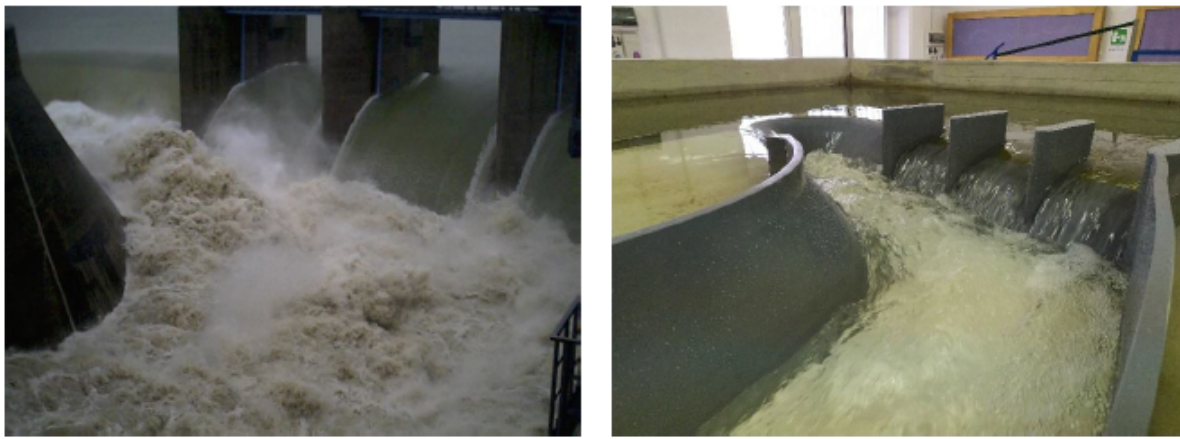
Figure 9. Comparison between the 2003 flow event (on the left) and the model scale reproduction (on the right).